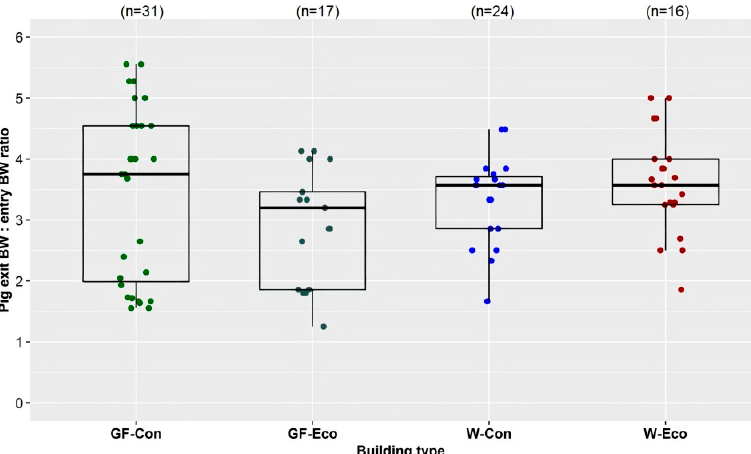
Figure 5. Pig exit bodyweight:entry bodyweight ratio by building type (GF-Con: Q1: 1.99, Median: 3.75, Mean: 3.41, Q3: 4.55; GF-Eco: Q1: 1.86, Median: 3.2, Mean: 2.94, Q3: 3.46; W-Con: Q1:3.21, Median: 3.57, Mean: 3.48, Q3: 3.77; W-Eco: Q1: 3.11, Median: 3.43, Mean: 3.47, Q3: 3.86). GF-Con = conventional grower/finisher buildings (solid/slatted/mesh floored pens), GF-Eco = grower/finisher eco-shelters (straw-floored pens), W-Con = conventional weaner buildings (sol-